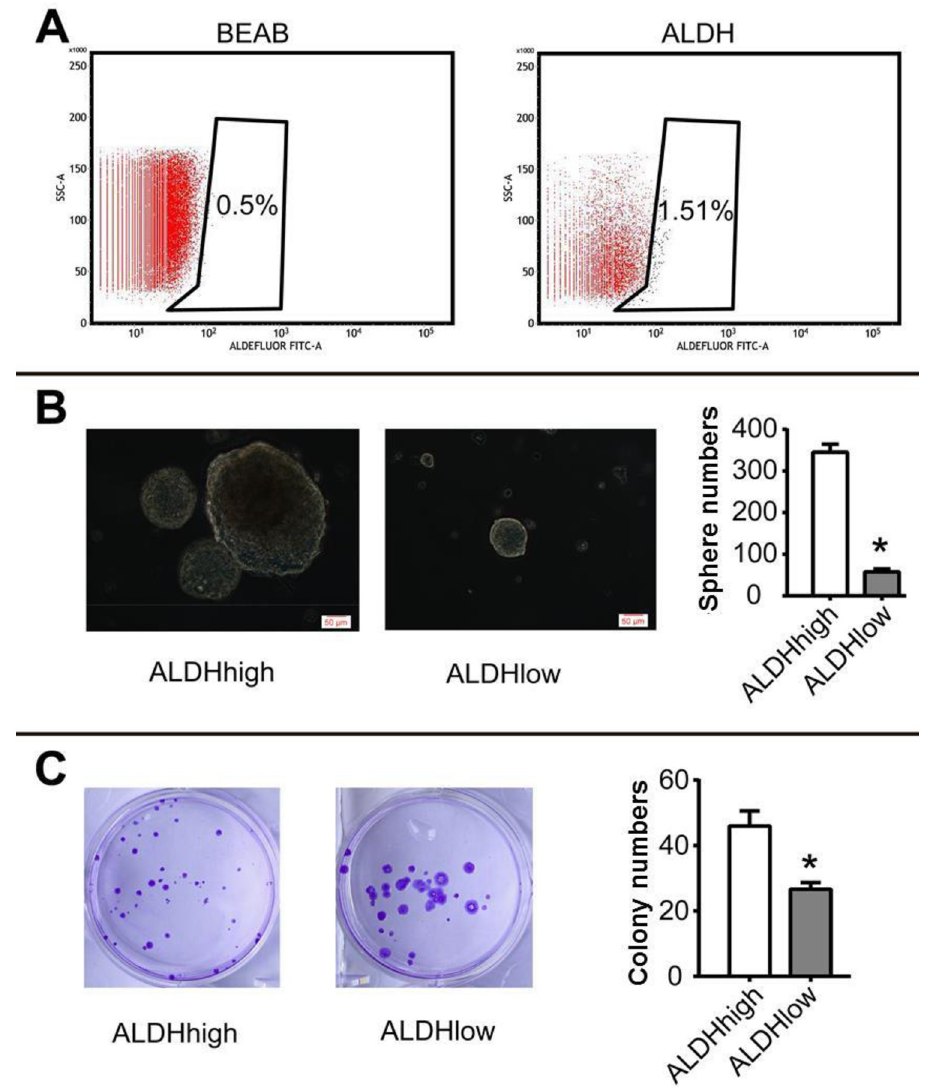
Fig 1. Identification of ALDHhigh tumor cells. (A) Flow cytometry sorting of ALDHhigh and ALDHlow tumor cells; (B) Sphere forming ability of ALDHhigh and ALDHlow cells; (C) Plate colony formation ability of ALDHhigh and ALDHlow cells; Scale bar: 50 μ m; � P <